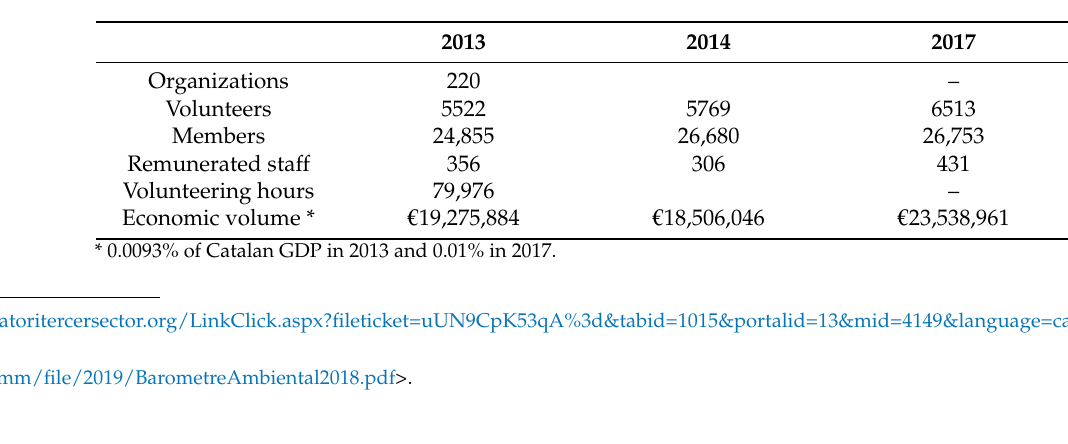
Figure 10. Priority area of action of Catalan environmental third sector organizations. Source: 2015 Barometer of the Environmental Third Sector. Table 20. Overall figures and estimates for the environmental third sector in Catalonia. Source: 2015 Barometer of the Environmental Third Sector and 2018 Environmental